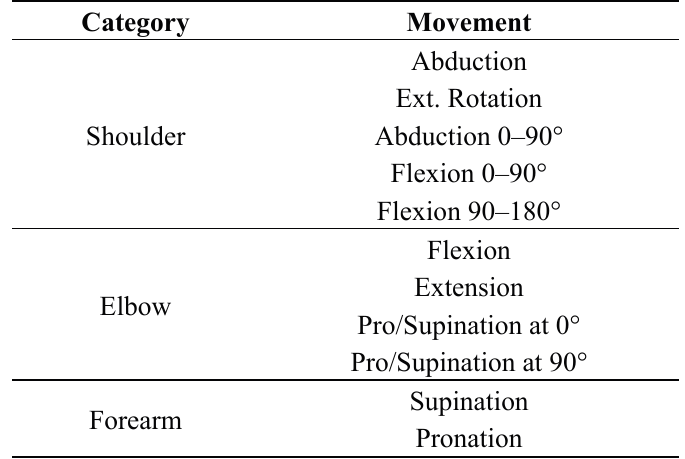
Figure 6. The primary user interface for our system, which shows a graphical representation of the Kinect’s sensor data. Table 2. The FMA tests supported by our implementation of an automated assessment